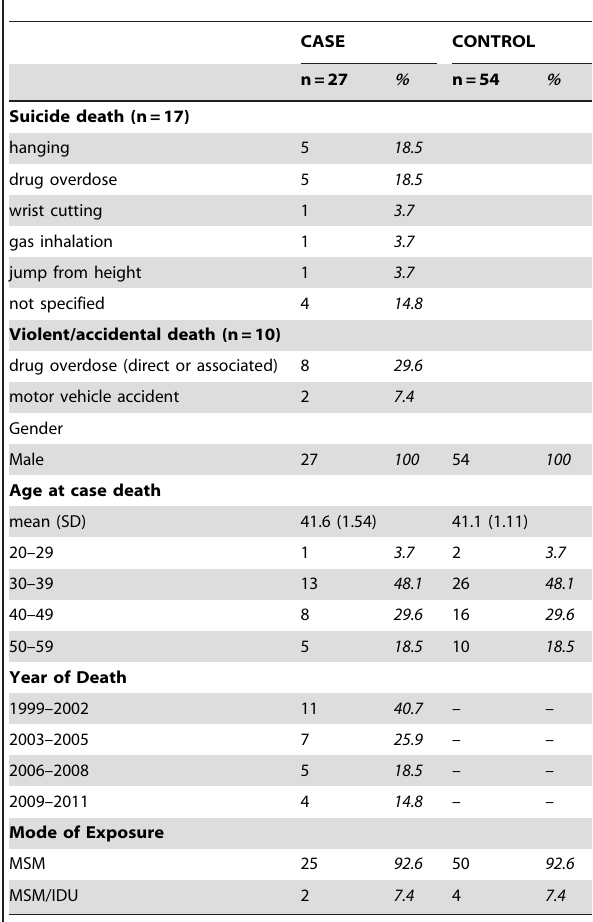
Table 1. Characteristics used for case control selection 1